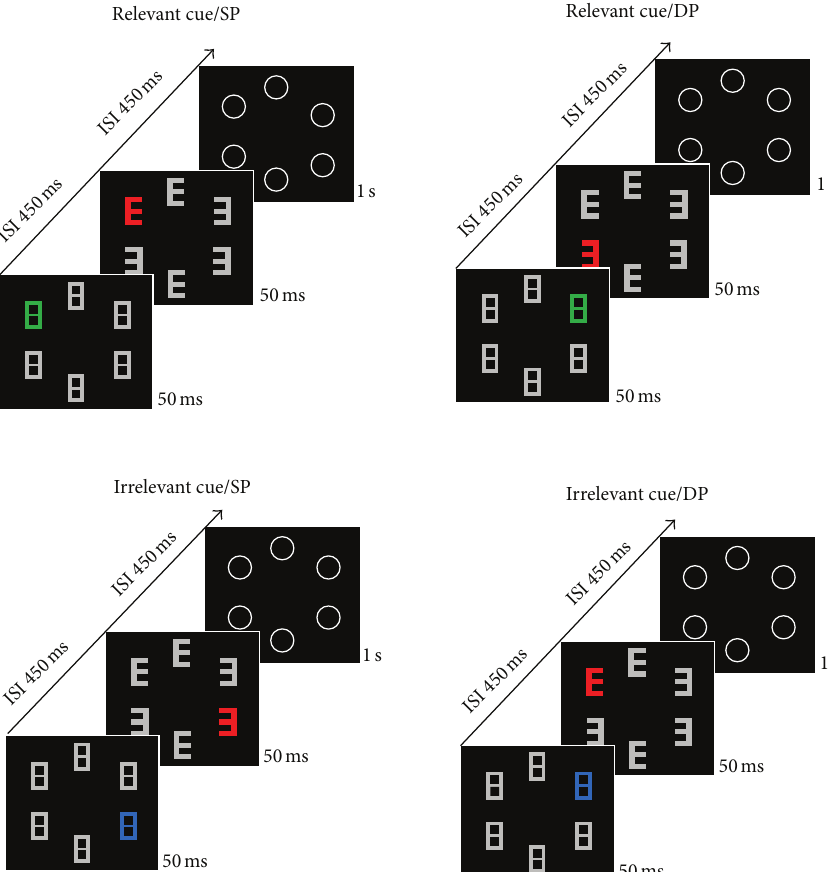
Figure 1: Depicted are examples of a different-position (DP) trial with a relevant cue (in the upper right), a same-position (SP) trial with a relevant cue (in the upper left), a different-position (DP) trial with an irrelevant cue (in the lower right), and a same-position (SP) trial with an irrelevant cue (in the lower left). In each of the four depicted conditions, the first (lower) display was the cue display, in which a color singleton cue (illustrated as a green or blue shape-8) was presented. The second (middle) display was the discrimination display where participants had to memorize the identity (i.e., shape- 𝐸 or shape-3) at the position of a relevant cue (here: green) but not after an irrelevant cue (here: blue) in the first display. Alongside the discrimination target, we presented a red color singleton as a saccade cue. The third (upper) display was the saccade display; participants had to saccade to the target ring at the position cued by the red singleton. The arrow illustrates the temporal sequence. Stimuli are not drawn to scale. ISI = interstimulus